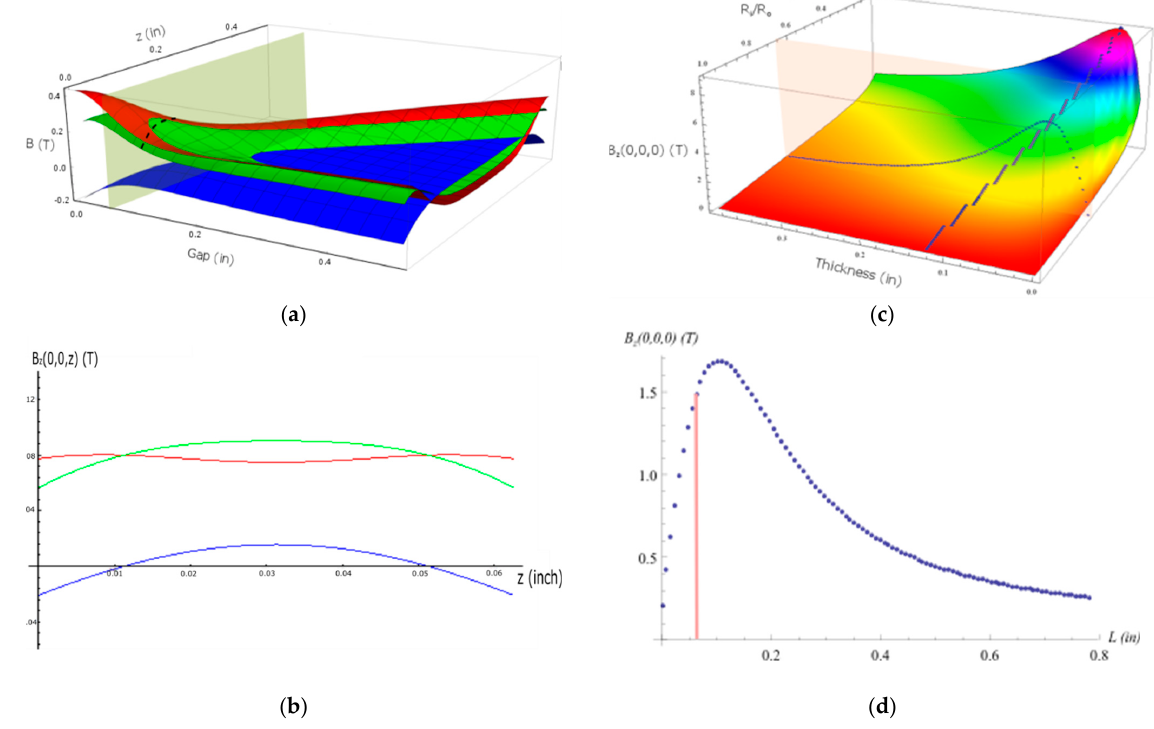
Figure 6. Simple Biöt-Savart axial (z-axis) simulation plots: ( a ) B z (z, Gap)—attracting pair (red), repelling pair (blue), sum (green), system position slice and sum curve (shaded plane and dotted line); ( b ) B z (z, Gap = 0.125 ″ ), 0.125 ″ Gap size due to coils modeled at the center point of 1/16 ″ thick magnet, i.e., actual gap (1/16 ″ ) + 2 * coil offset (1/32 ″ )—attracting pair (red), repelling pair (blue), sum (green); ( c ) single magnet face center B z (Ri/Ro, thickness)—colored Ri/Ro iso-bands high- light ratio behavior, maximum values (black dots), system slice and curve (shaded plane and green broken curve); ( d ) single magnet face center B z (for Ri/Ro = 0.67) vs. thickness L—system position at red line. Antiparallel magnetization directions sum depending on gap size. Axial (z-axis) field strength is also influenced by the ratio of inner radius (R i ), outer radius (R o ), and thickness of each magnet. In Figure 6c, solenoid simulation identifies the optimum thickness and R i /R o values. However, thickness and outer diameter (OD) selection were constrained by commercially available options: 1/8 ″ or 1/16 ″ and OD (2R o ) desired to 3/8 ″ (mentioned earlier), respectively. Conceptually, a smaller thickness would be preferable when the an- nular magnet is modeled as inner and outer solenoids. Thicker magnets relative to outer diameter tend to the infinite coil solution where the axial fields sum vanishes. Axial fields of the inner and outer coils are equal and opposite. Jackson’s [9] (p. 225) solenoid-faces- subtending-angles solution shows this behavior, see Figure 7. Figure 7. Thick-magnet axial field behavior (N = coil turns per length, I = current). In other words, the outer loop’s negative impact on the sum axial (B z ) field is reduced by the largest possible OD. Experiment apparatus 3/8 ″ available space, therefore, sets the OD.3/8 (cid:48)(cid:48) OD constraint and commercial unavailability of 3/8 (cid:48)(cid:48) × 1/4 (cid:48)(cid:48) × 1/16 (cid:48)(cid:48) forced customization of 3/8 (cid:48)(cid:48) × 1/8 (cid:48)(cid:48) × 1/16 (cid:48)(cid:48) via Dremel-lathe working to widen the 1/8 (cid:48)(cid:48) inner diameter (ID) to 1/4 (cid:48)(cid:48) to allow sufficient atom transit time as discussed shortly. Commercial annular magnets are sintered powders encased in a thin metallic jacket; in this case, Ni- Cu-Ni. Usual cutting tools result in fracturing and disintegration. Grinding proved to be a viable option. The four customized annular magnets were evaluated for geometric individuality. A total of 0.7% variance in thickness was the most differing characteristic noted. Figure 8a shows the typical measured transverse (x-axis) B z profile for a single annular magnet. The center face “surface” field is ~400 G, and the center ring surface